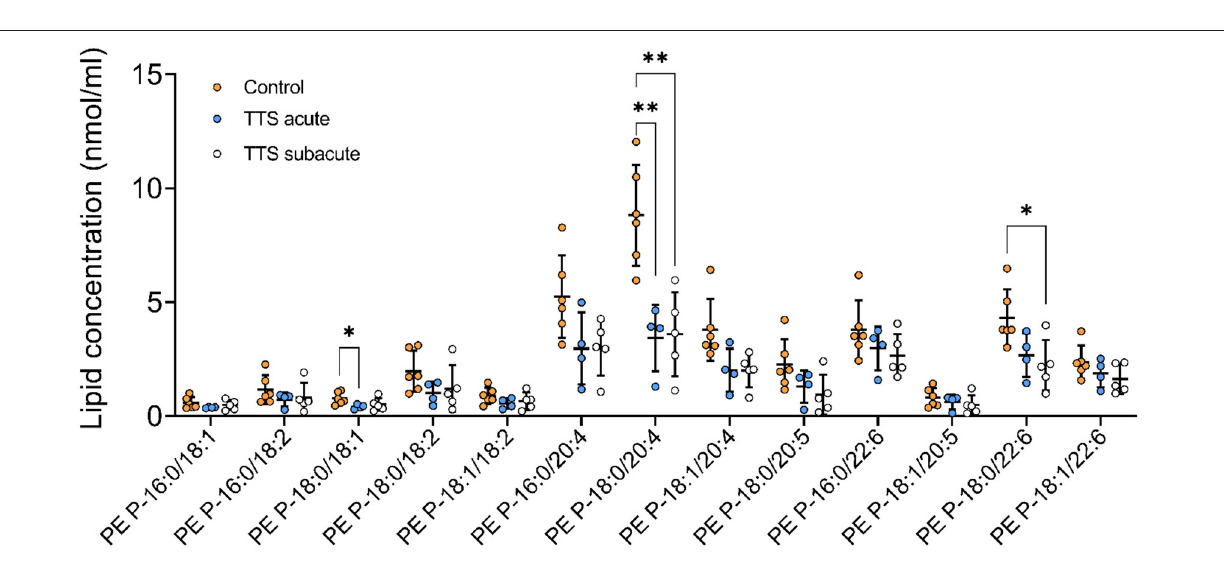
FIGURE 6 | Composition of individual PE P lipid species in the acute TTS, subacute TTS, and control groups. Values are represented as nmol/ml. Values are mean ± SD, P -value: ** P < 0.01, * P < 0.05. Where significance is not mentioned, values are considered as being not significant. PE P, PE based plasmalogen; TTS, Takotsubo